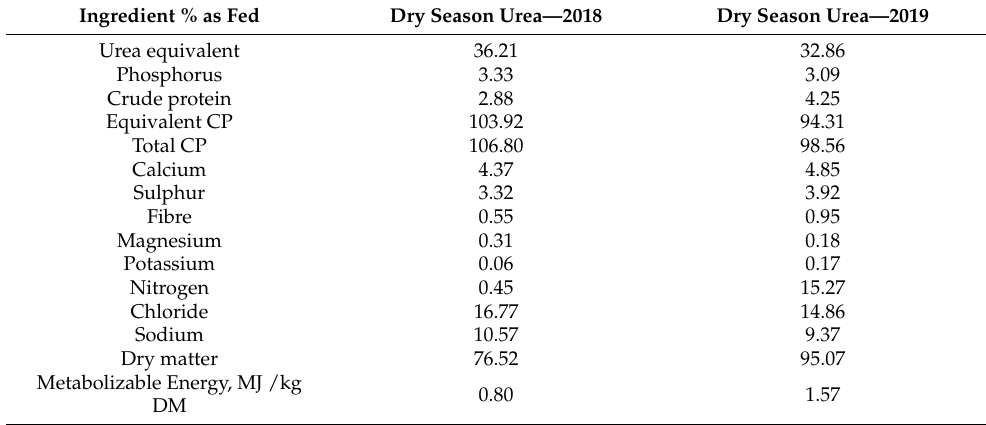
Table 1. Nutritional information of dry season supplements for breeding animals under extensive conditions in northern